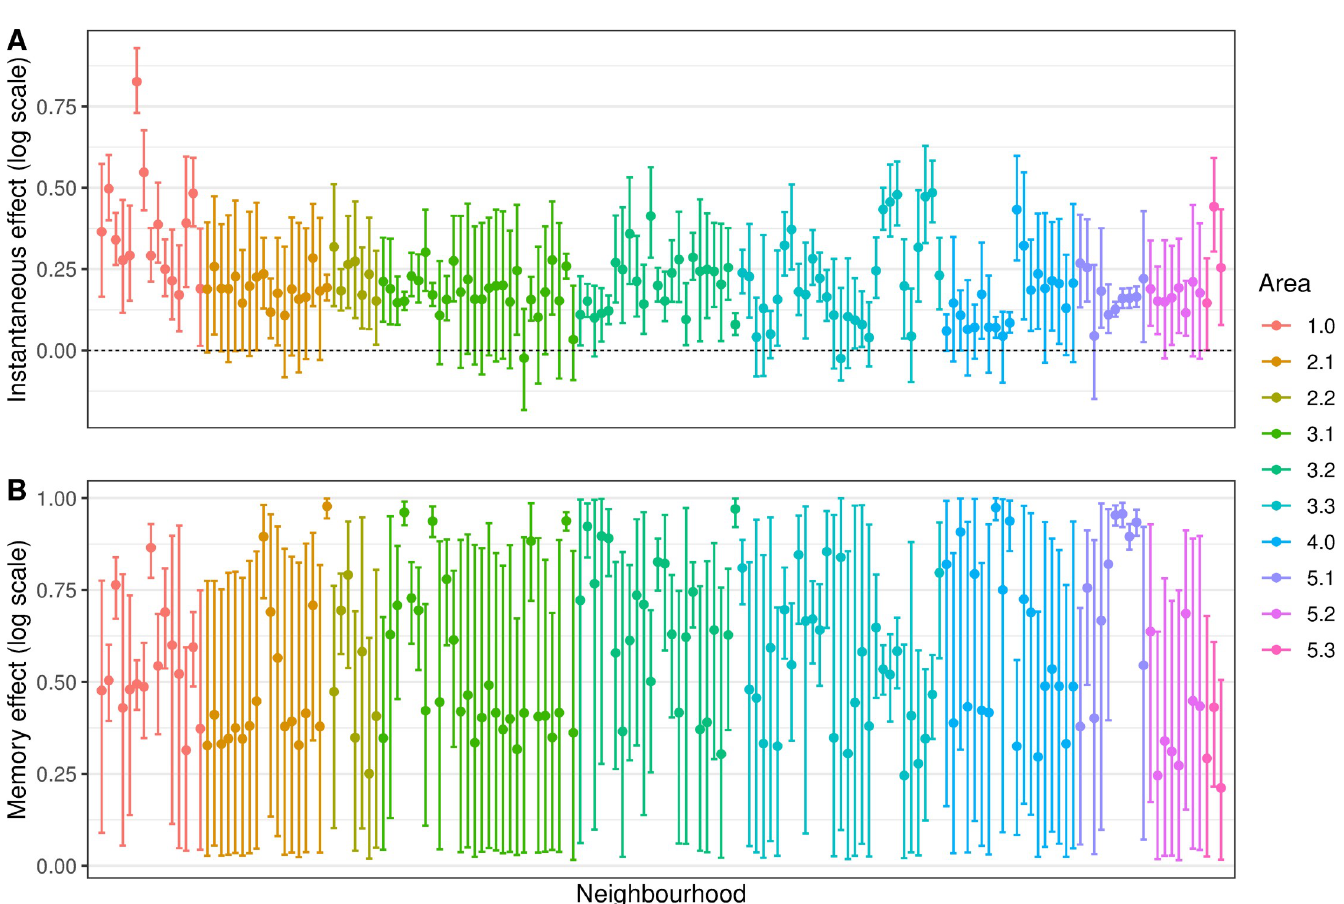
Fig 7. Minimum temperature instantaneous effect (in the same week) (A) and memory effect (B) on chikungunya cases (in the log scale) by neighbourhood, mean and 90% credible interval, controlling for sociodevelopment index and proportion of green areas, and the latent spatial effect, weeks 9 to 52 2016, Rio de Janeiro city, Brazil.